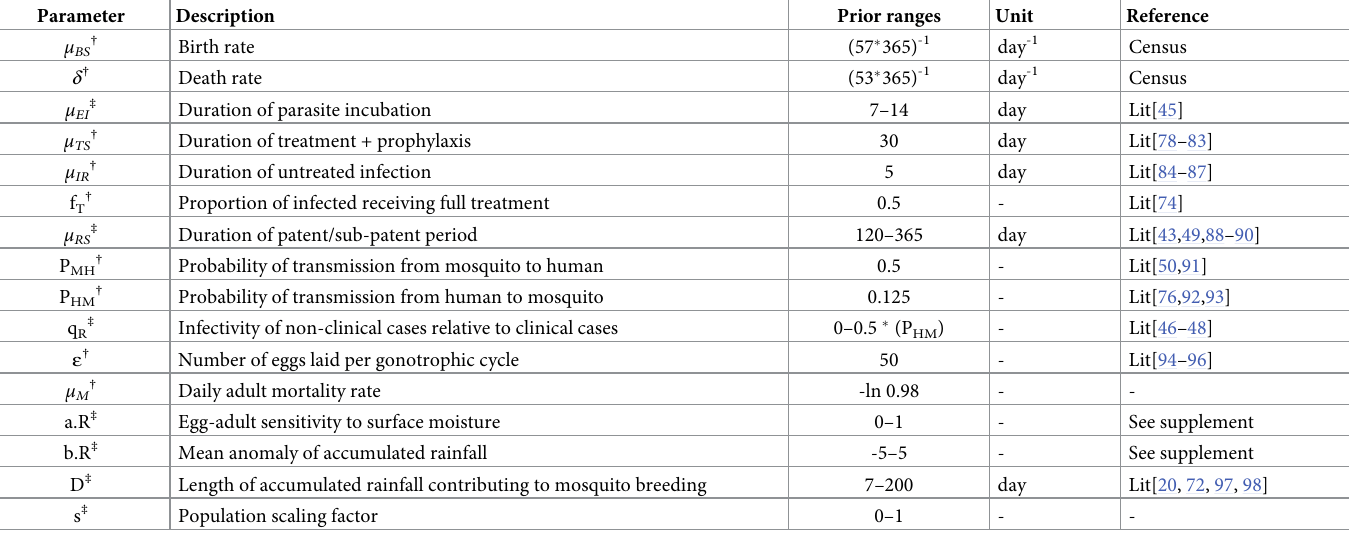
Table 2. Description of the parameters of the malaria transmission model.